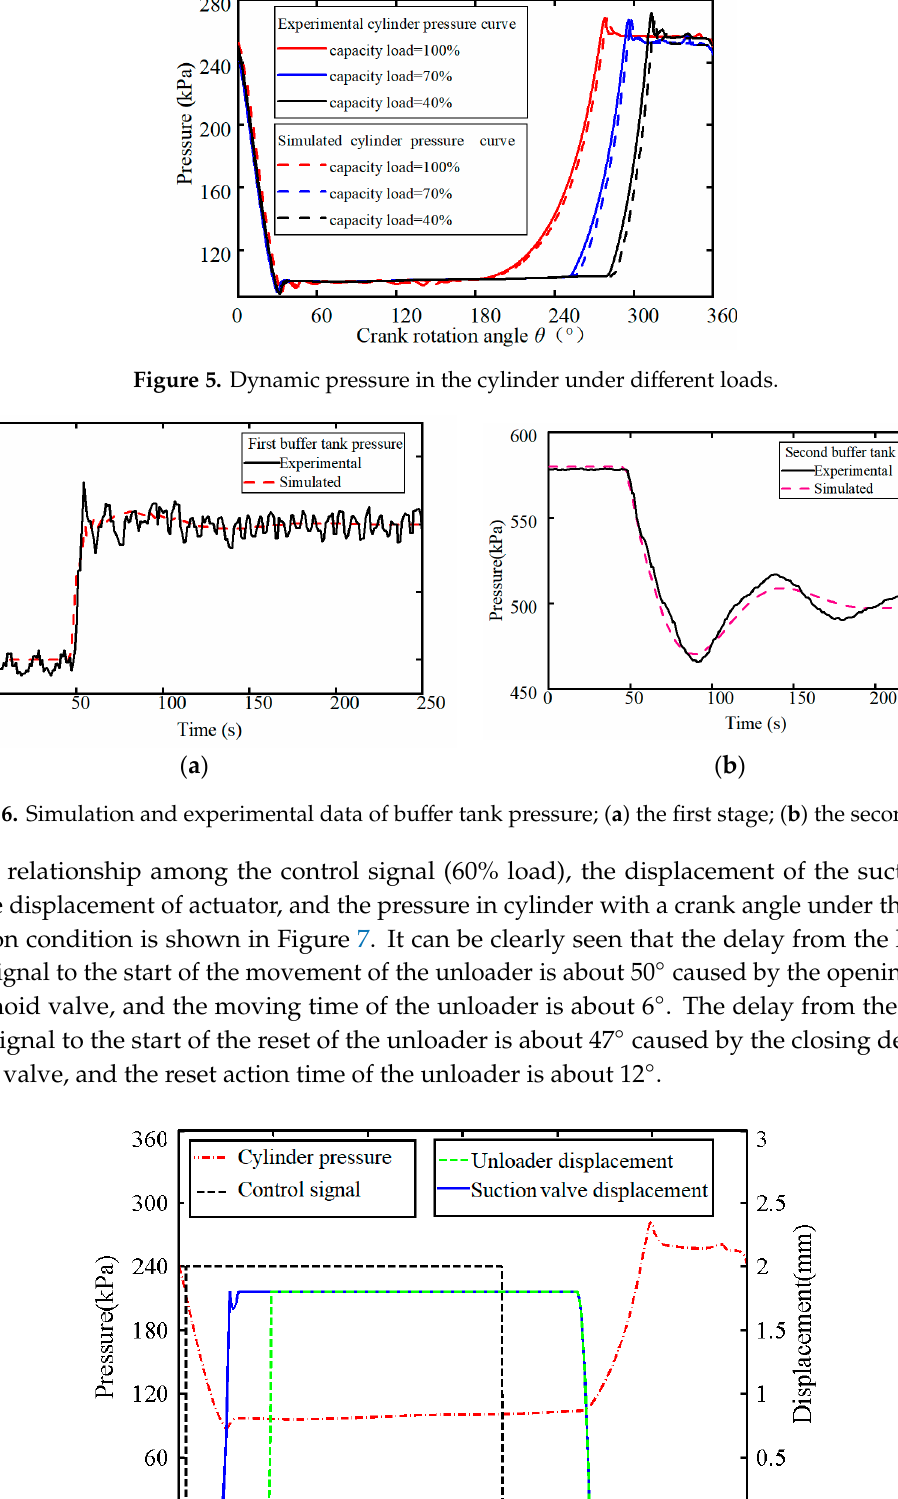
Figure 7. Control signal, suction valve plate, unloader, and cylinder dynamic pressure.